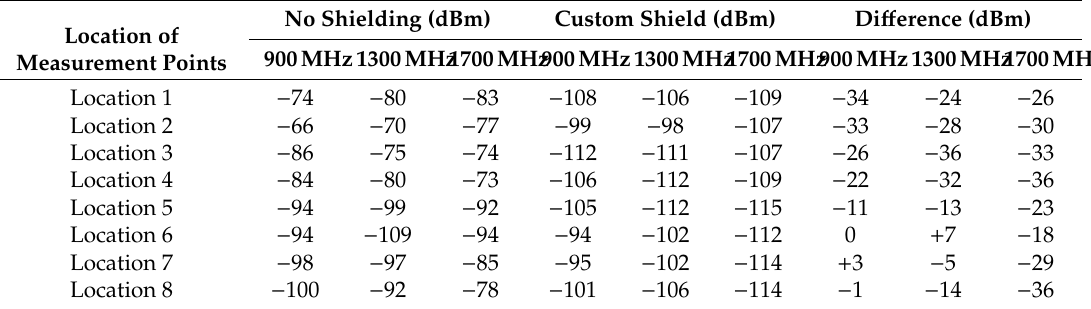
Table 2. Measured leakage signal values at 900, 1300, and 1700 MHz for circuit board locations with: ( a ) no shield and ( b ) shielded housing, respectively, for Channel 2. Location of